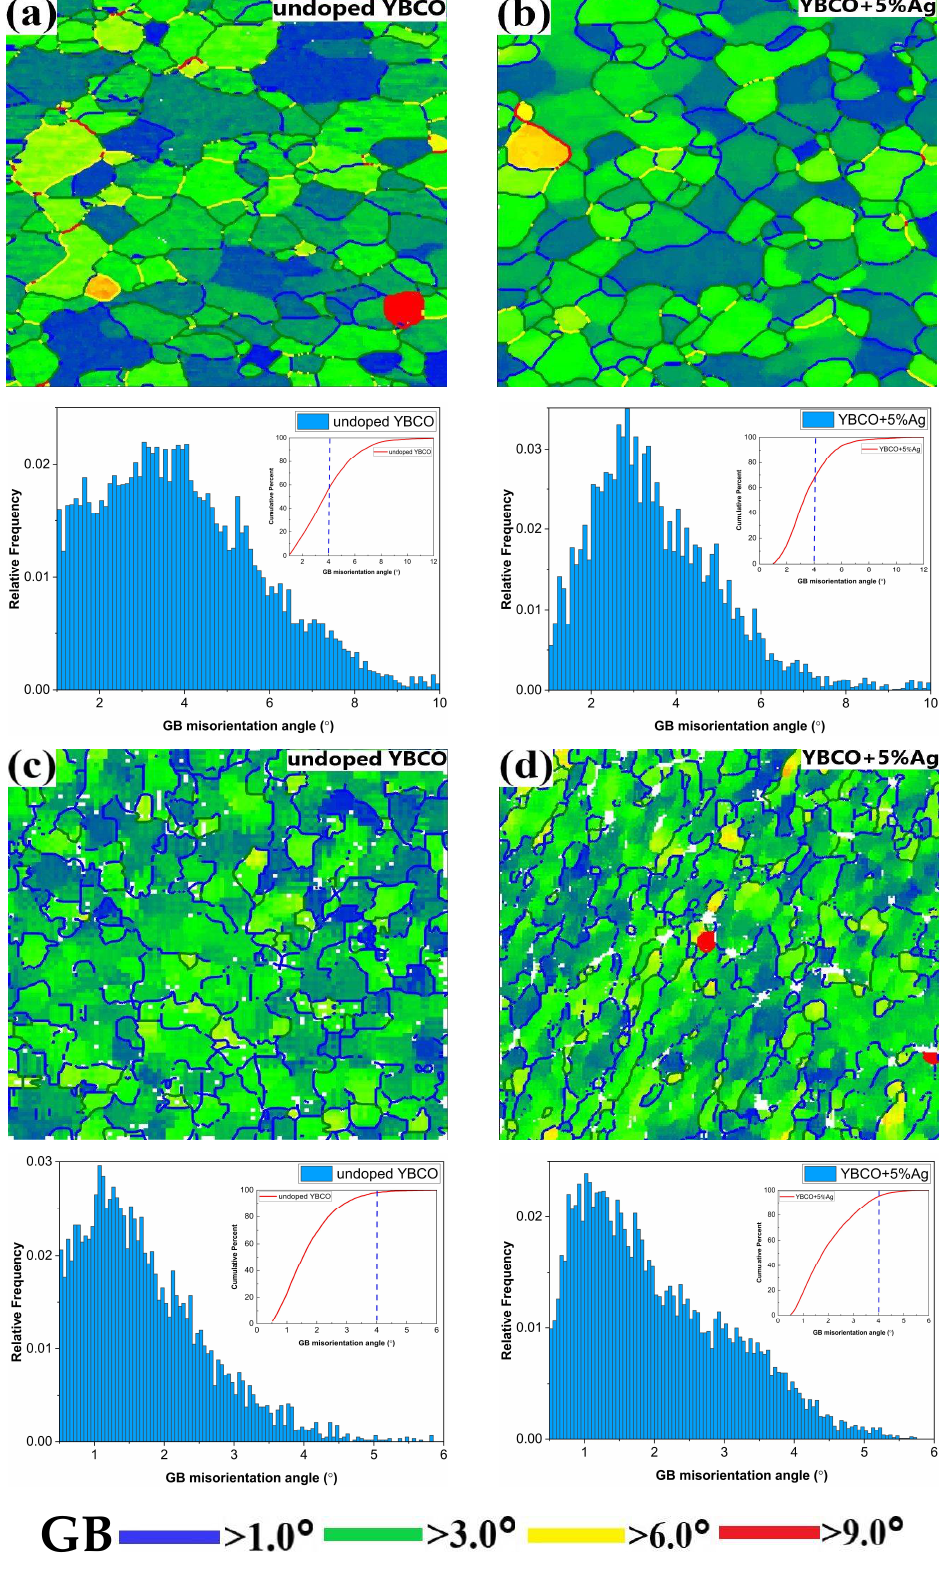
Figure 3. EBSD maps of the absolute misorientation (AMO) with noise reduction and marked grain boundaries for films on RABiTS ( a , b ) and IBAD − MgO ( c , d ). The grain boundary analysis was carried boundaries for films on RABiTS ( a , b ) and IBAD−MgO (c , d ). The grain boundary analysis was car- out with the MTex tool ried out with the MTex tool box.